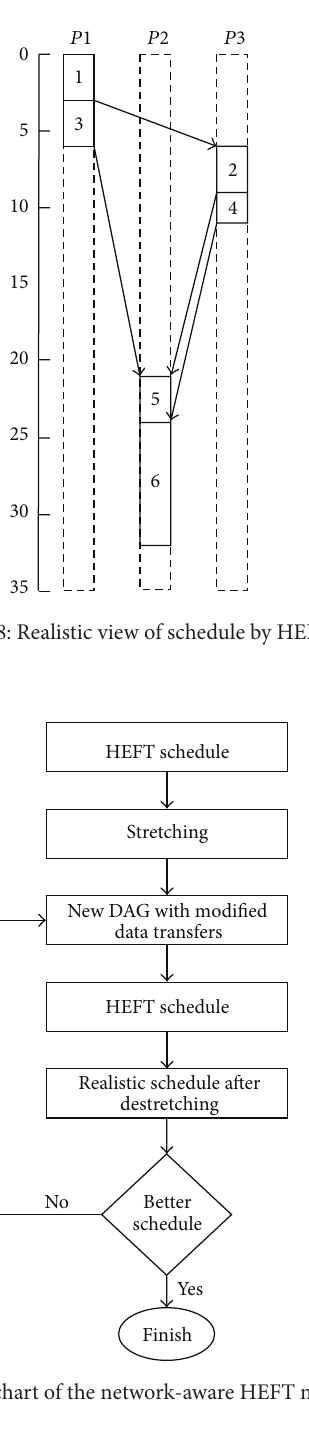
shows an increment of 37.52 % in the makespan of the original schedule produced by